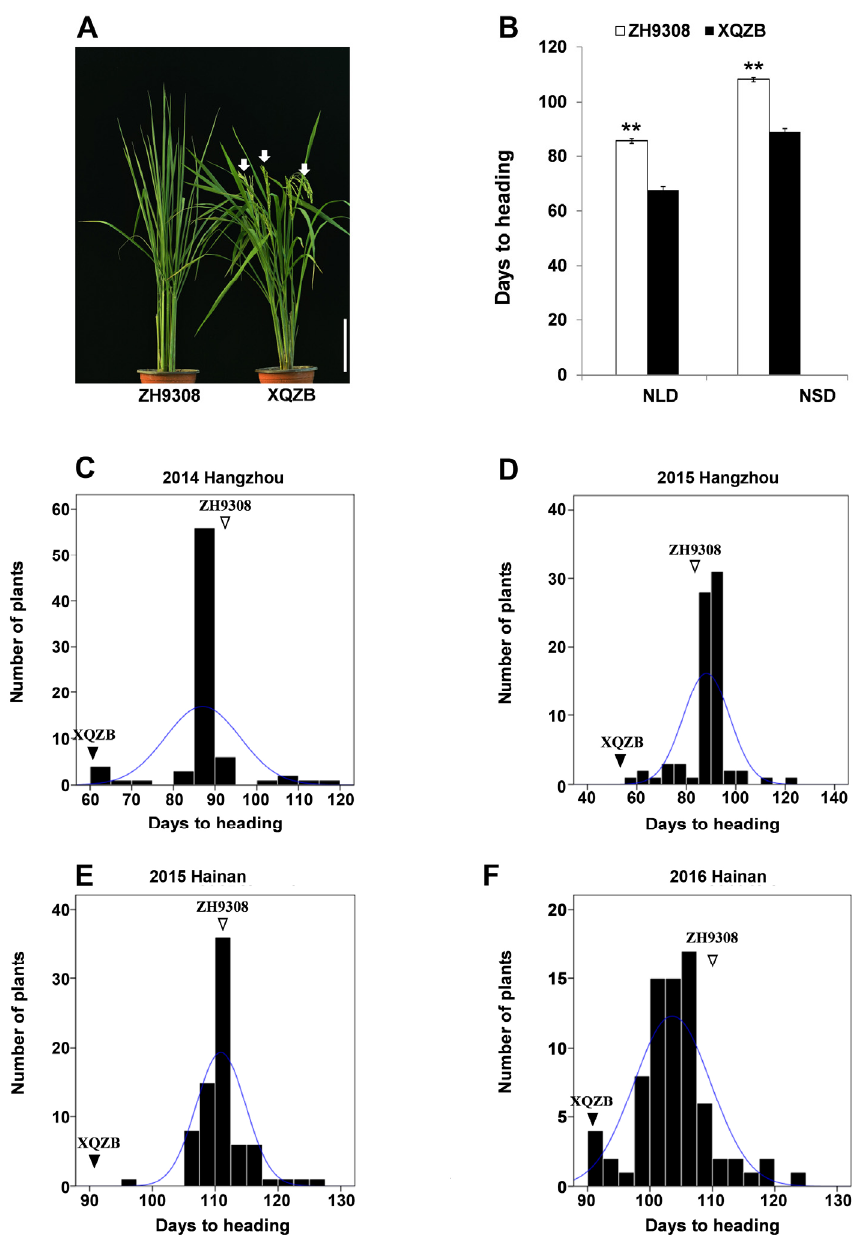
Figure 1. Comparison of ZH9308 and XQZB parents with ** indicating significant differences at p < 0.01 ( A – B ) and heading date distribution of the 76 chromosome segment substitution lines (CSSLs) based on the best linear unbiased prediction (BLUP) evaluated at the Hangzhou and Hainan growing conditions ( C – F ).